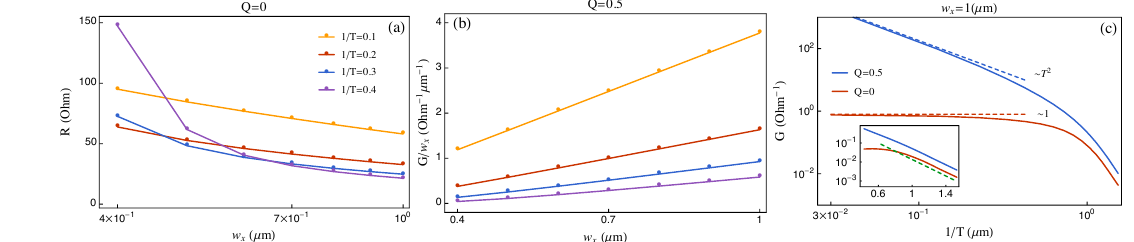
Figure 12: (a): log-linear plot of resistivity against the width w at various T at x zero density. At high T in the Ohmic regime, R ∼ − log w ; while lowering T , R x enhances at small w but keeps Ohmic scaling at large w with decreased R . (b): x x conductance over width against the width at various T at finite density. At high T in the viscous regime, G ∼ w 2 ; while at low T , G approximately has the same viscous x scaling but with decreased G . (c): log-log plot of conductance against 1 / T . At high T , G ∼ constant for zero density while G ∼ T 2 for finite density. After decreasing T below 1 / T ∼ w , two curves coincide at the scaling G ∼ exp ( − α (cid:48) / T ) ( α (cid:48) ≈ 5 as x shown in the inset) indicating the quantum critical